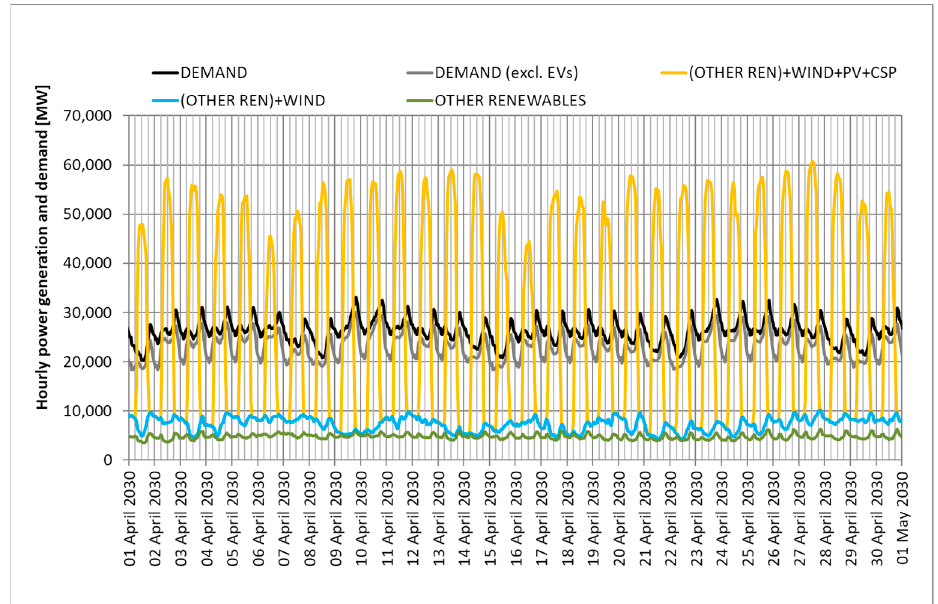
Figure 3. Projected hourly electricity demand and potential generation (i.e., pre-curtailment and storage) for the month of April 2030, in the “Low BEV” scenario.